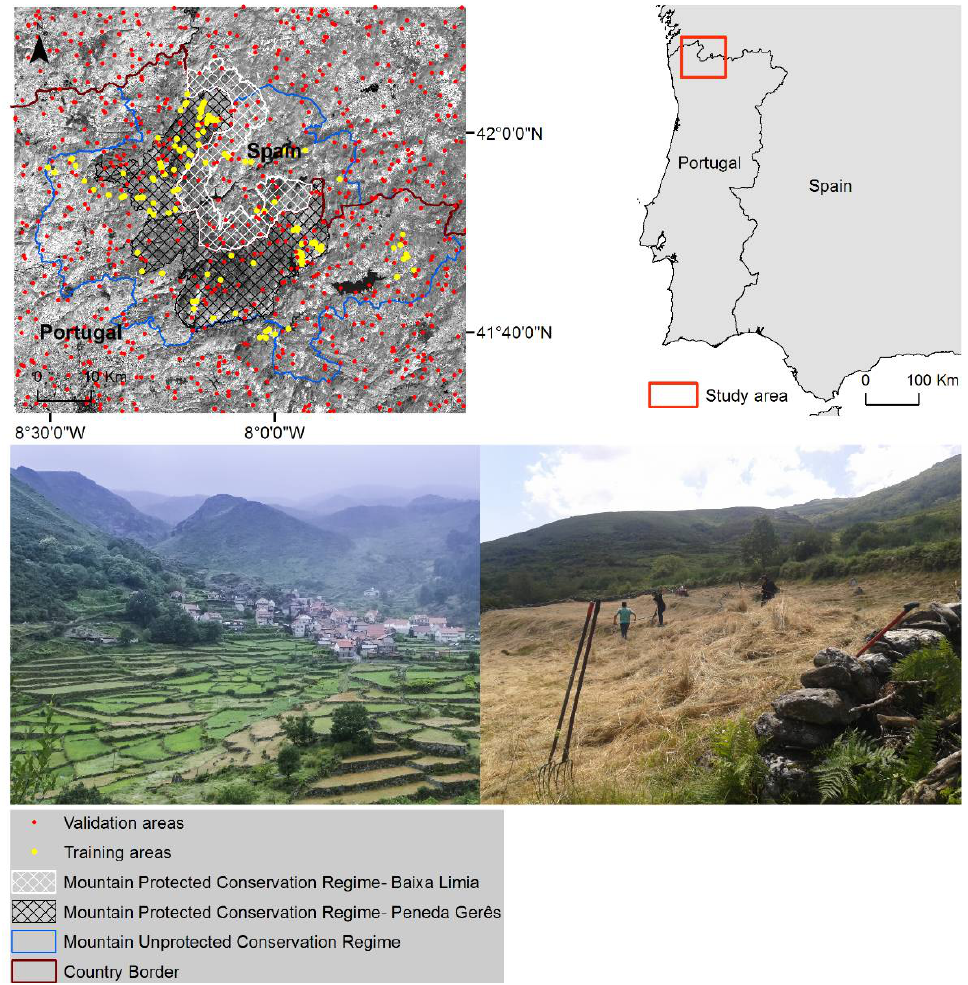
Figure 1. The transboundary mountain region located between Portugal and Spain in the Iberian Peninsula. In the upper panels, the study area is captured by the greenness tasseled component derived from Landsat imagery of February 2019. The study area is composed of a mountain domain that comprises an extent of protected (Peneda – Gerês National Park, Portugal; Baixa Limia-Serra do Xurés Natural Park, Spain) and unprotected land conservation regimes (in blue). The mountain domain overlaps the administrative boundaries of the transboundary Gerês – Xurés Biosphere reserve. The remaining areas surrounding the mountain domain were defined as lowlands. The areas used for training and validation are also presented. The lower panels show an example of the traditional terraced grasslands and of the local practices of hay collection in the summer season.